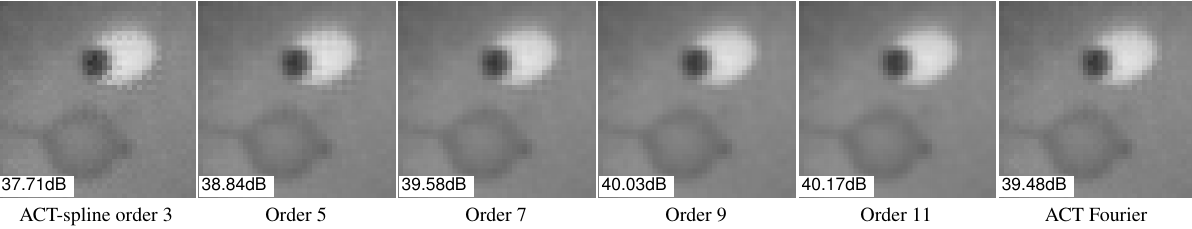
Figure 3. Crops from the fusion of 15 frames with Gaussian noise of standard deviation σ = 2 / 255 and ground-truth registration except for one frame with an offset of (+1 , +1) pixel (zoom × 2 ). Notice how the artifacts due to the misregistration disappear with high-orders spline